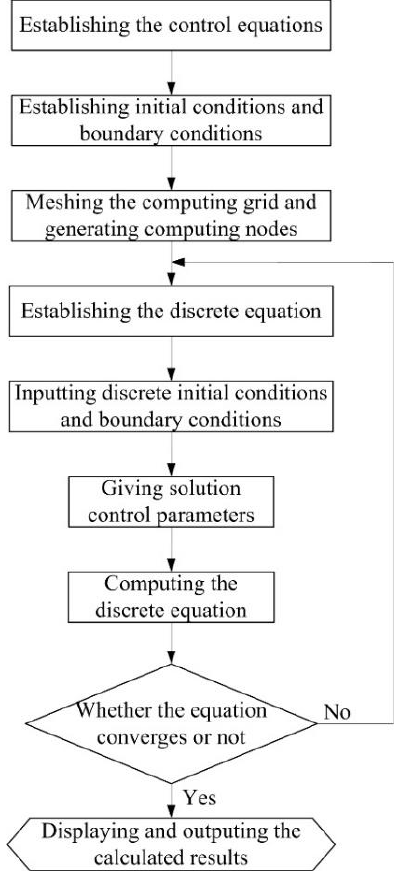
Figure 4. Flowchart of CFD calculation .